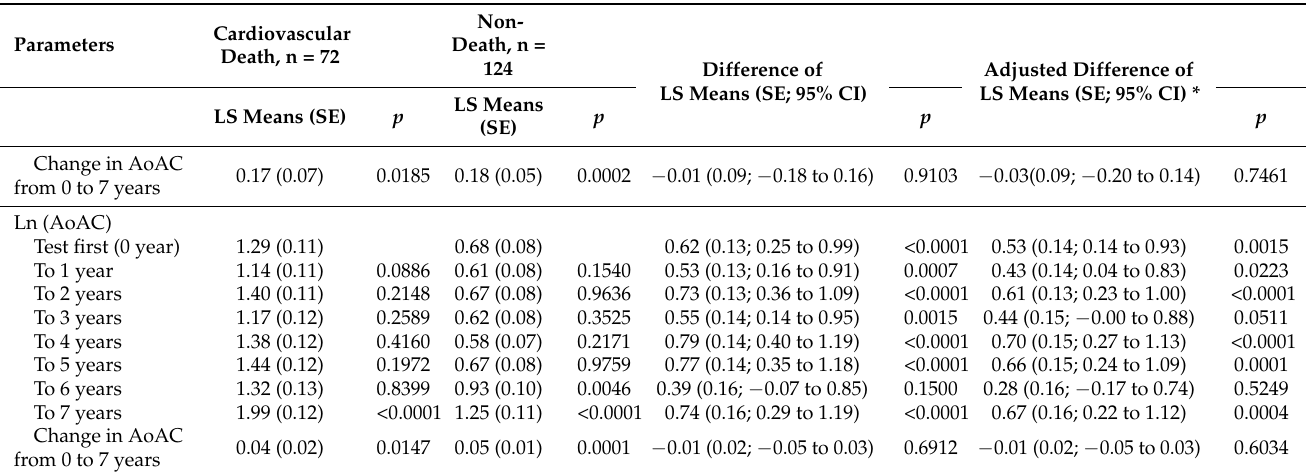
Abbreviations as Table 2: * Change in mean differences was adjusted for age > 60 years old, smoking history, diabetes mellitus, coronary artery disease, cerebrovascular disease, duration of HD, albumin, fasting glucose, and antiplatelet agent use. The natural logarithm (Ln) of a number is its logarithm to the base of the mathematical constant